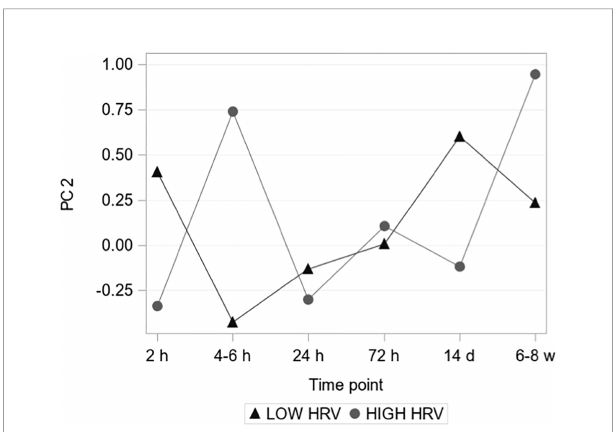
FIGURE 5 | Principal component 2. The second PC showed a signi fi cant group-time interaction assessed by a mixed-effects model (P = 0.013 < 0.05/ 3 = 0.017, i.e. after Bonferroni